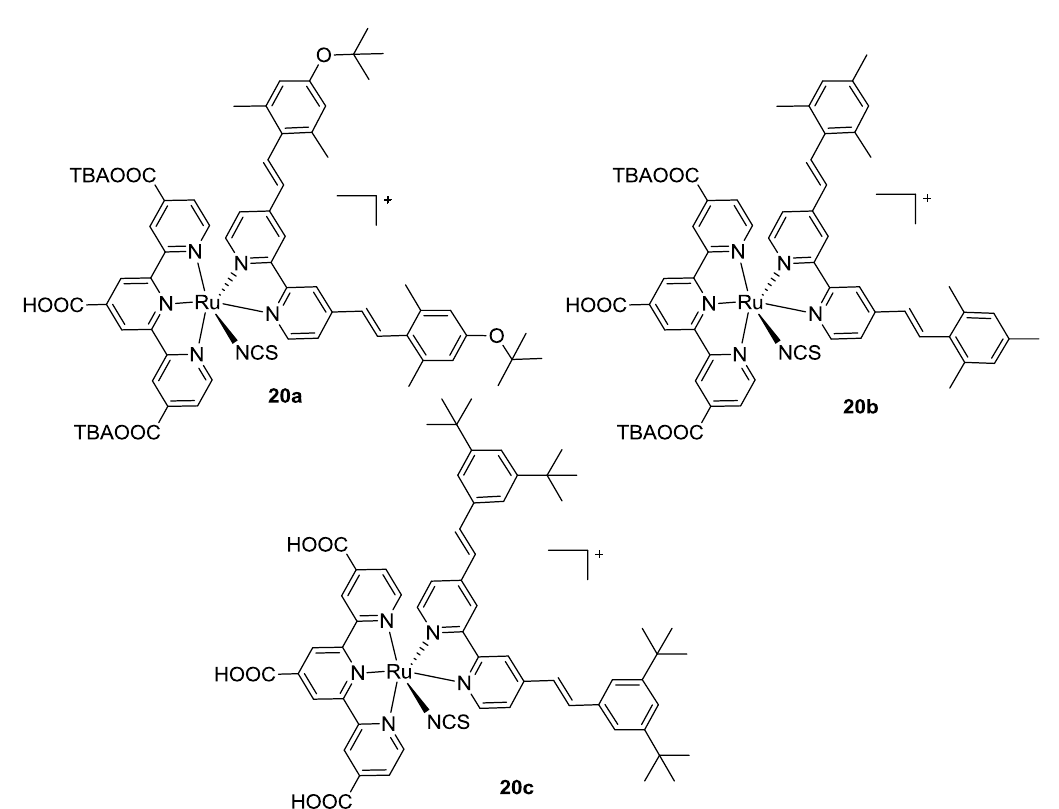
Figure 15. Monothiocyanate complexes proposed by Chandrasekharam [98] (top) and Giribabu [99] (bottom).